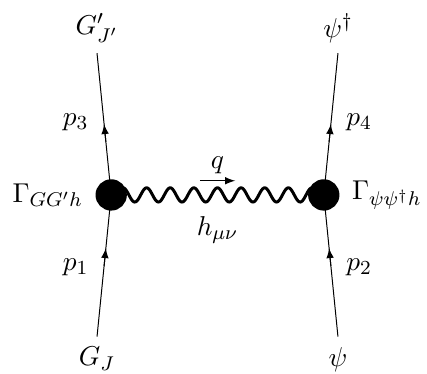
Figure 7 . Eikonal scattering set-up for the phase-shift δ GG 0 .